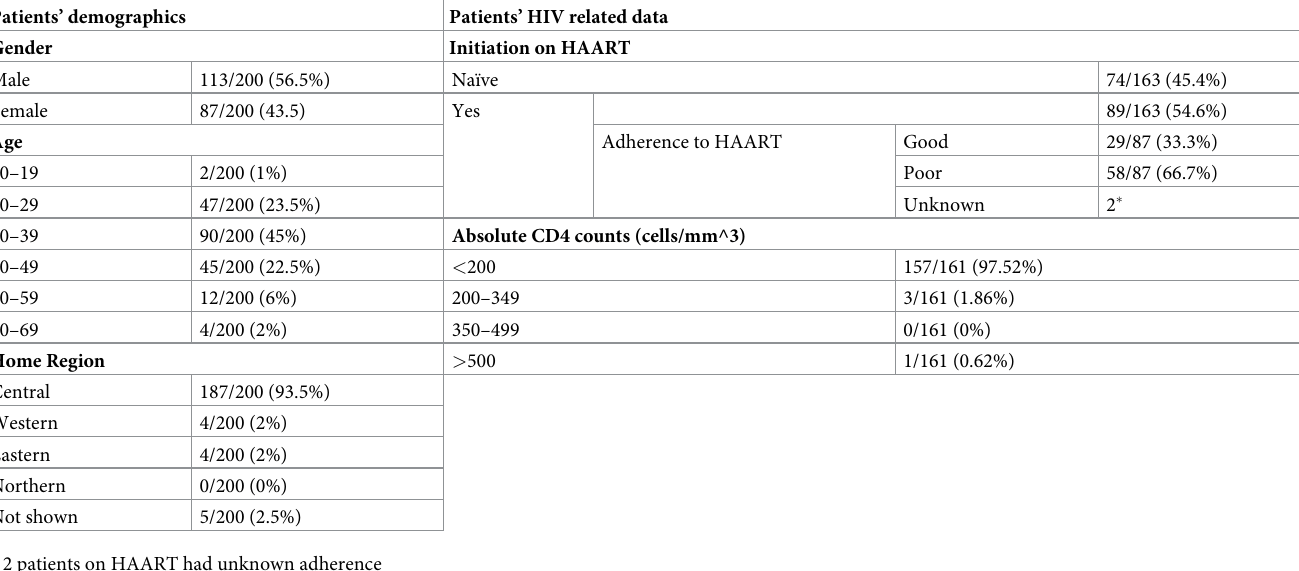
Table 1. Patients’ demographic characteristics and HIV related